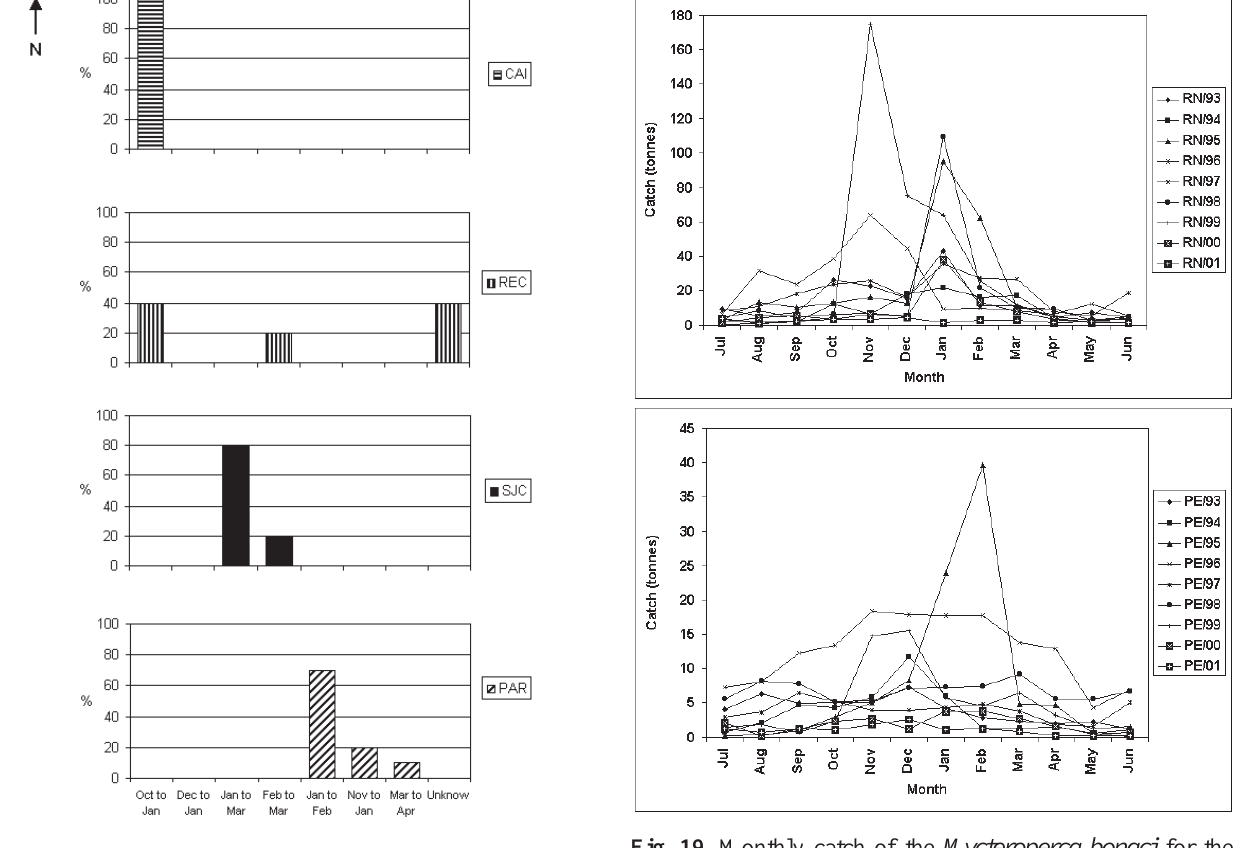
Fig. 19 . Monthly catch of the Mycteroperca bonaci for the states of Rio Grande do Norte (North area) and Pernambuco (South Area) from Northeast Fisheries Statistics Bulletin (IBAMA). RN: Rio Grande do Norte/year, PE: